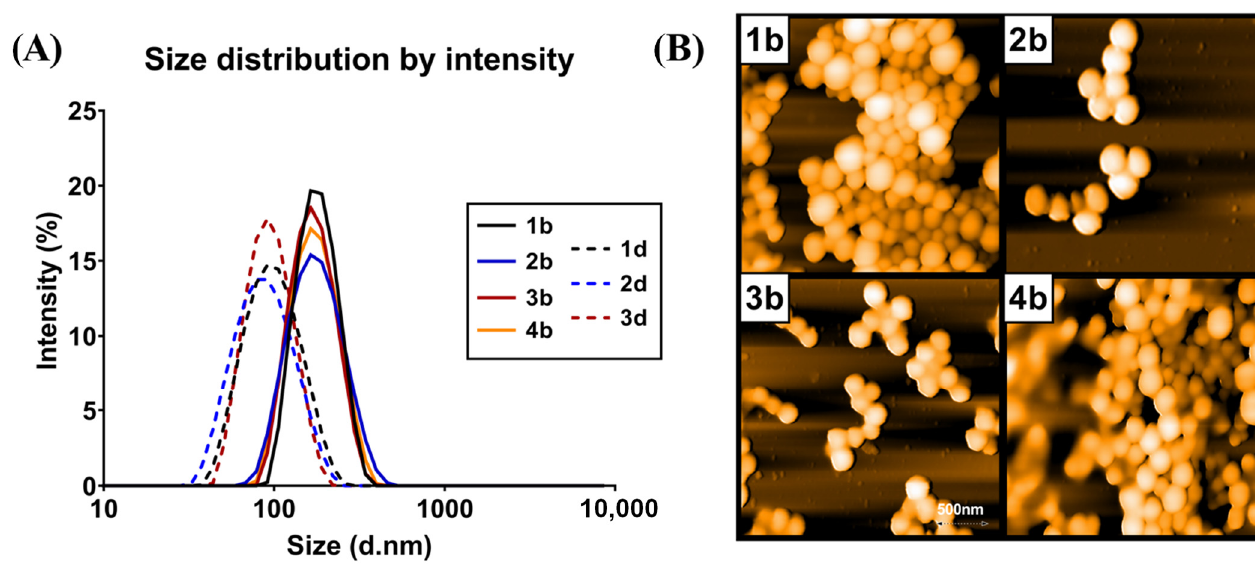
Figure 1. Granulometric characteristics of PLGA nanosphesres: ( A ) Size distribution by scattered laser light intensity of RhB loaded nanospheres; ( B ) atomic force microscopy (AFM) topographic images of samples ( 1b ), ( 2b ), ( 3b ) and ( 4b ) as described in Table 1. AFM was performed using the Nanosurf easyScan 2 FlexAFM instrument with samples diluted at the ratio 1:50 on a dried microscope slide.